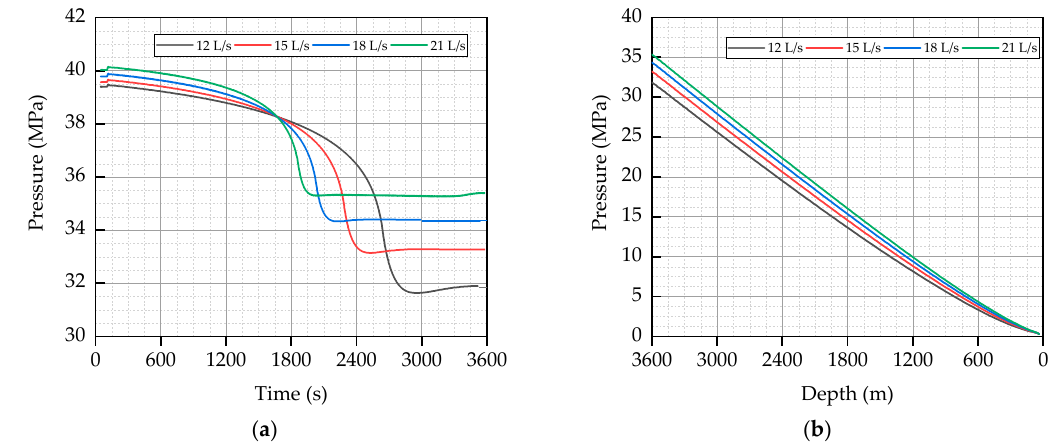
Figure 18. Variation in the bottom hole pressure at different liquid densities at different: ( a ) times; and ( b ) depths.